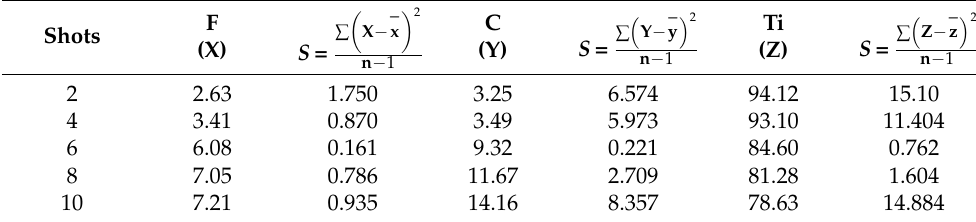
Table 1. EDX elemental composition of the samples. Shots